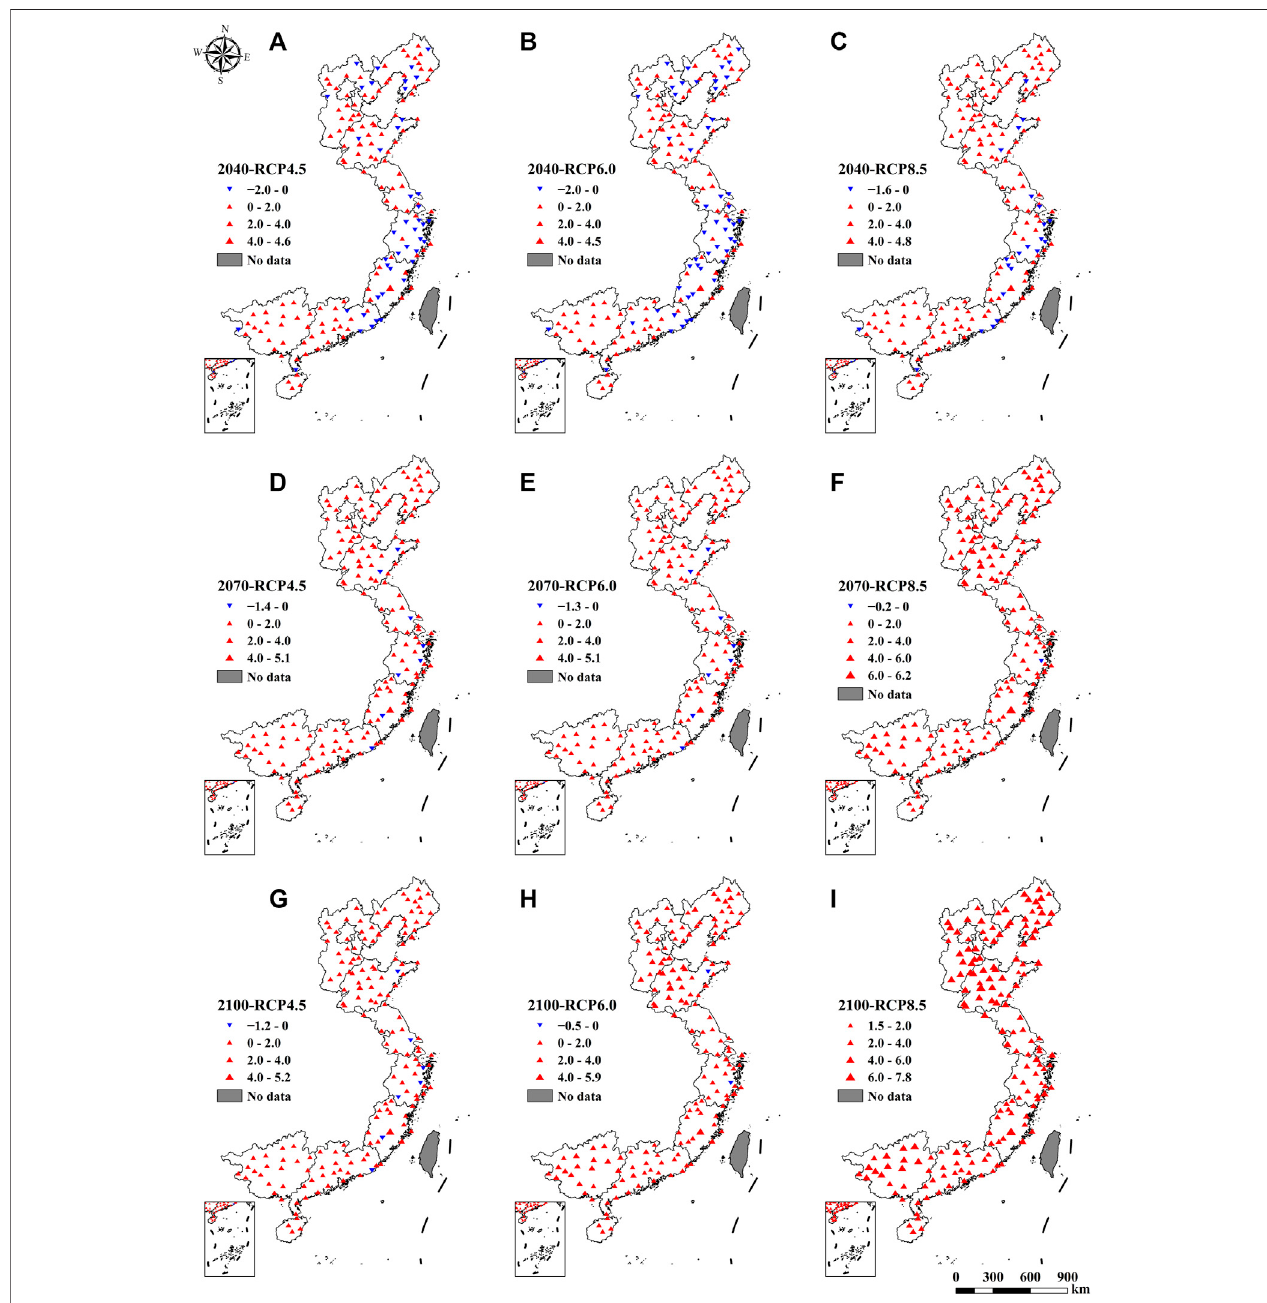
FIGURE 12 | Spatial distribution of changes in annual average Tmax for 2040 with RCP4.5 (A) , RCP6.0 (B) , RCP8.5 (C) , 2070 with RCP4.5 (D) , RCP6.0 (E) , RCP8.5 (F) and 2100 with RCP4.5 (G) , RCP6.0 (H) , RCP8.5 (I) relative to the base period 1996 -2018 at 162 meteorological stations over CAC.